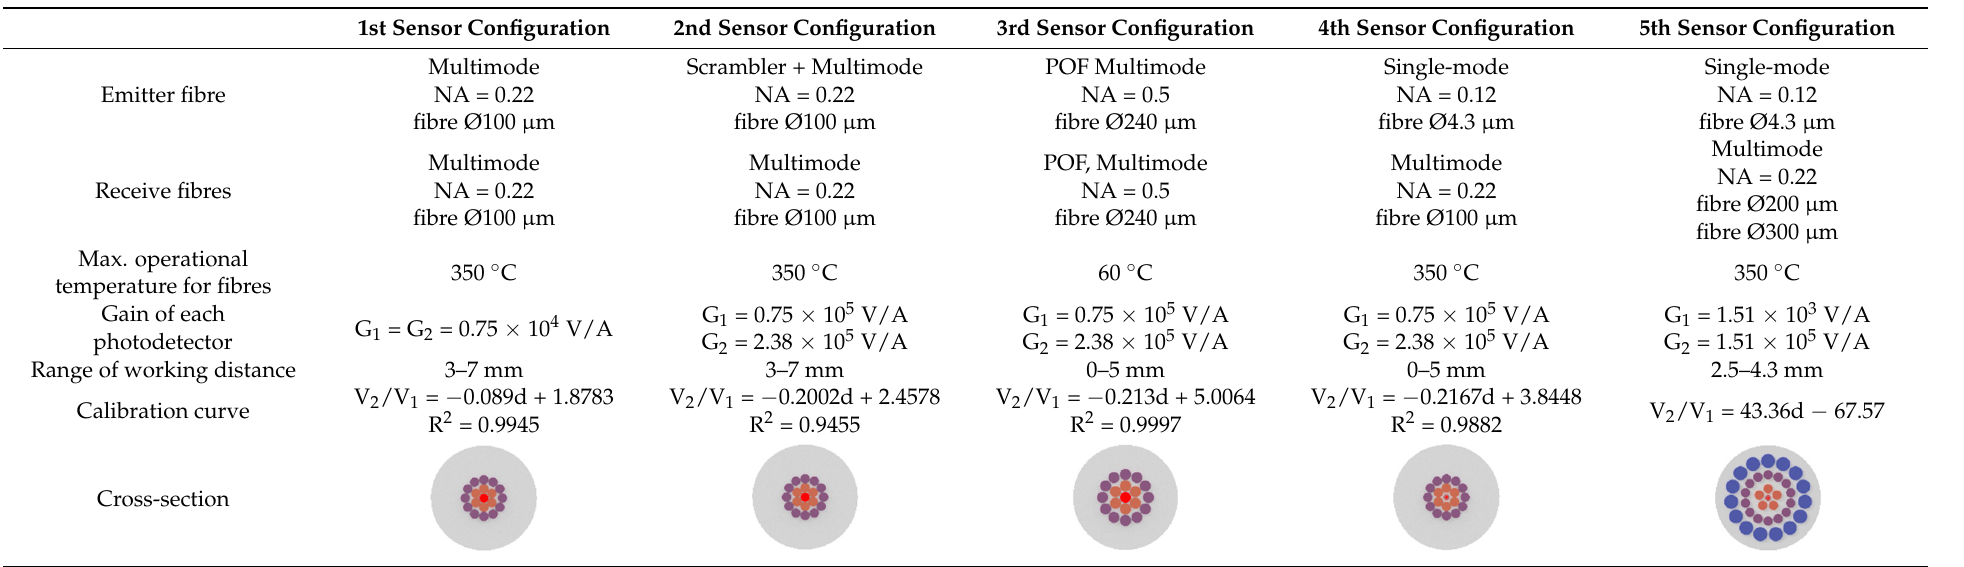
Table 1. Details of the different sensor